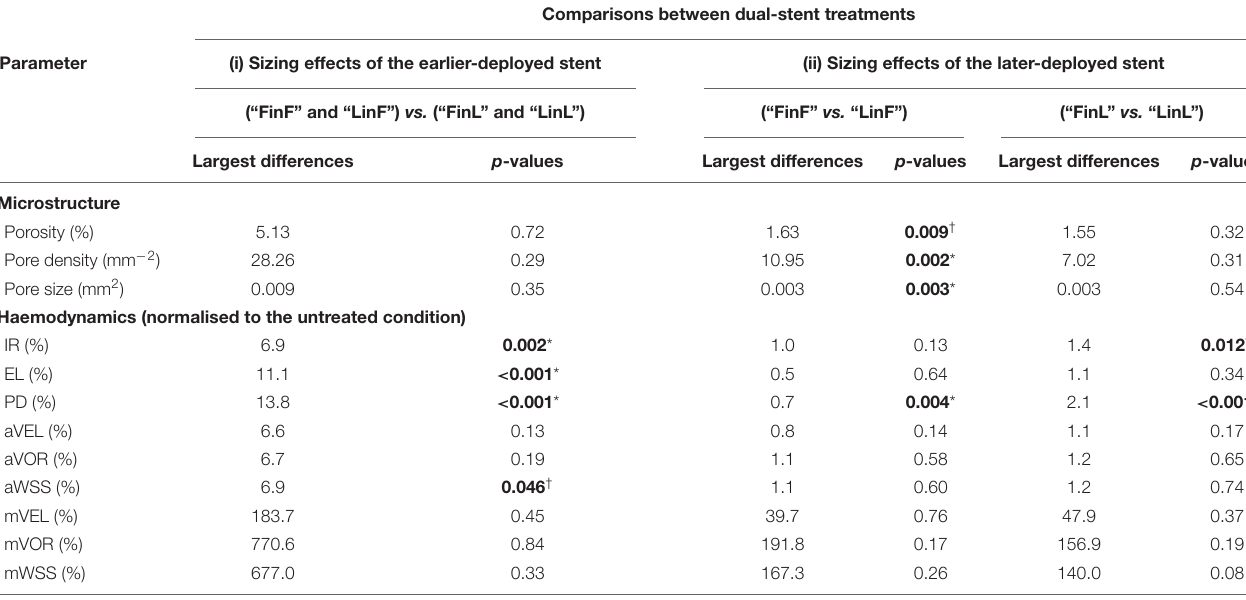
Comparisons between dual-stent